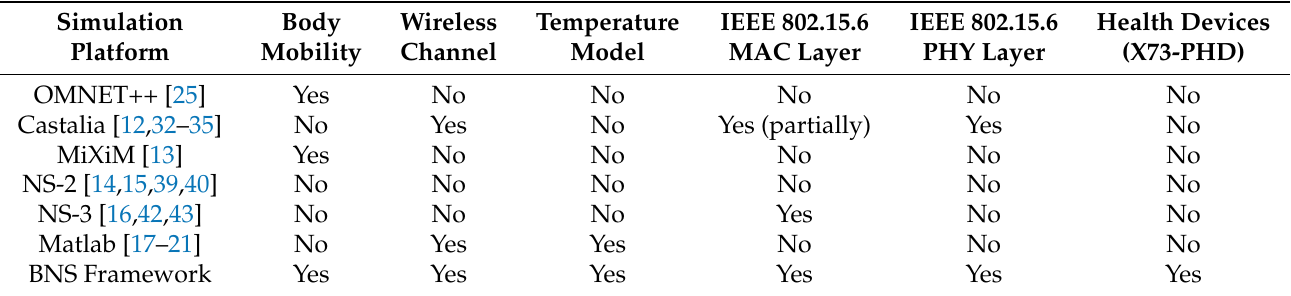
Table 1. Comparison of WBAN simulation